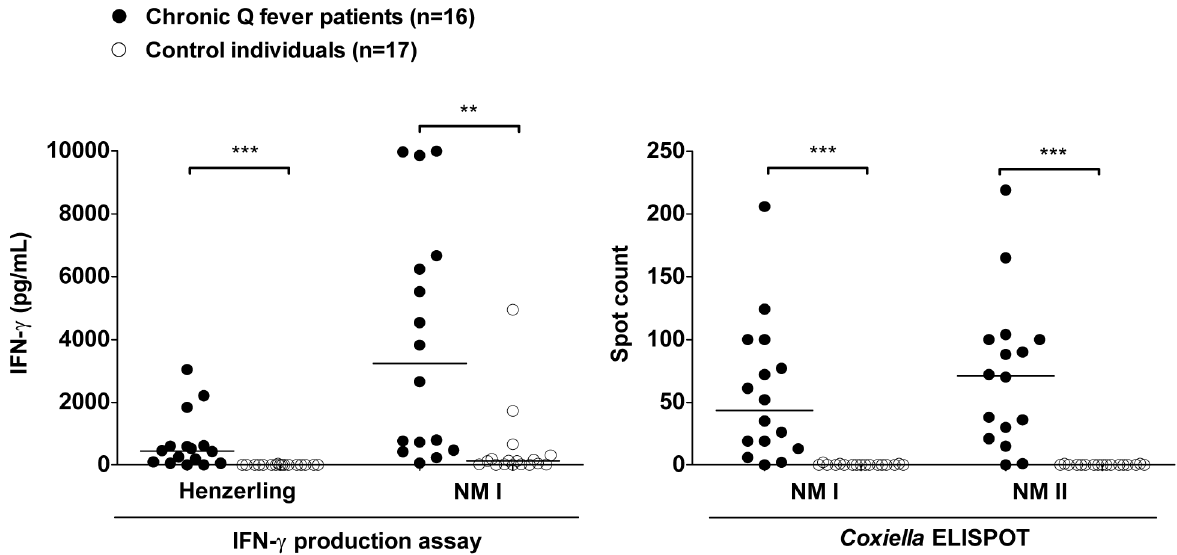
Figure 1. Results of the IFN- c production assay and Coxiella ELISPOT in chronic Q fever patients and control subjects. In vitro IFN- c production by whole blood in response to Henzerling and Nine Mile phase 1 antigens was measured in the IFN- c production assay. The number of IFN- c positive cells in response to Nine Mile phase 1 and Nine Mile phase 2 antigens was measured in the Coxiella ELISPOT. Individual values of patients and controls are shown separately, and the lines indicate the medians. Patients and controls were compared using the Mann-Whitney U -test.